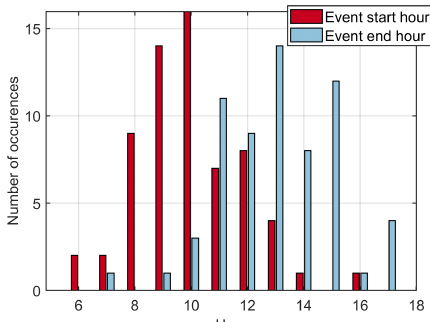
Figure B2. Bar plot shows the occurrence of event start and end times defined by the Dada et al. (2018) method during each hour of the day.